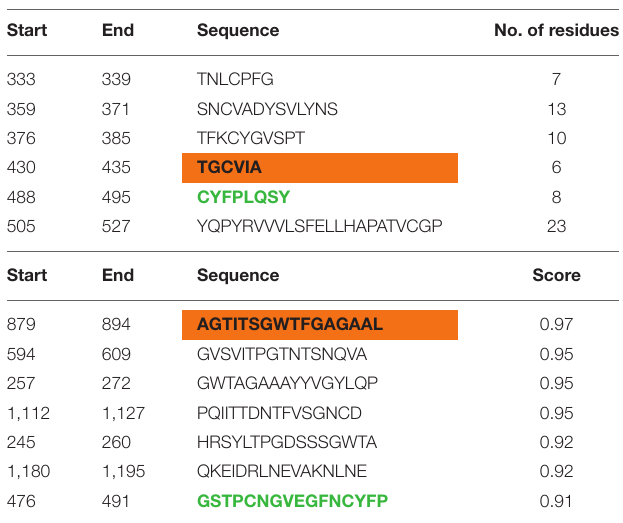
TABLE 4 | Representative predictive antigenic epitopes.